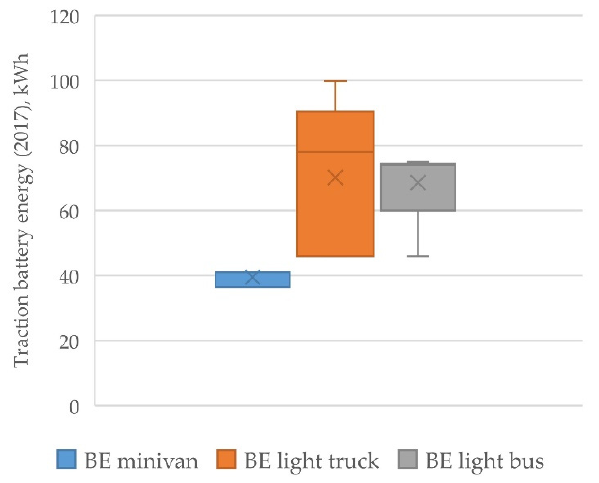
Figure 12. Battery capacity distribution for BELVs (2017).